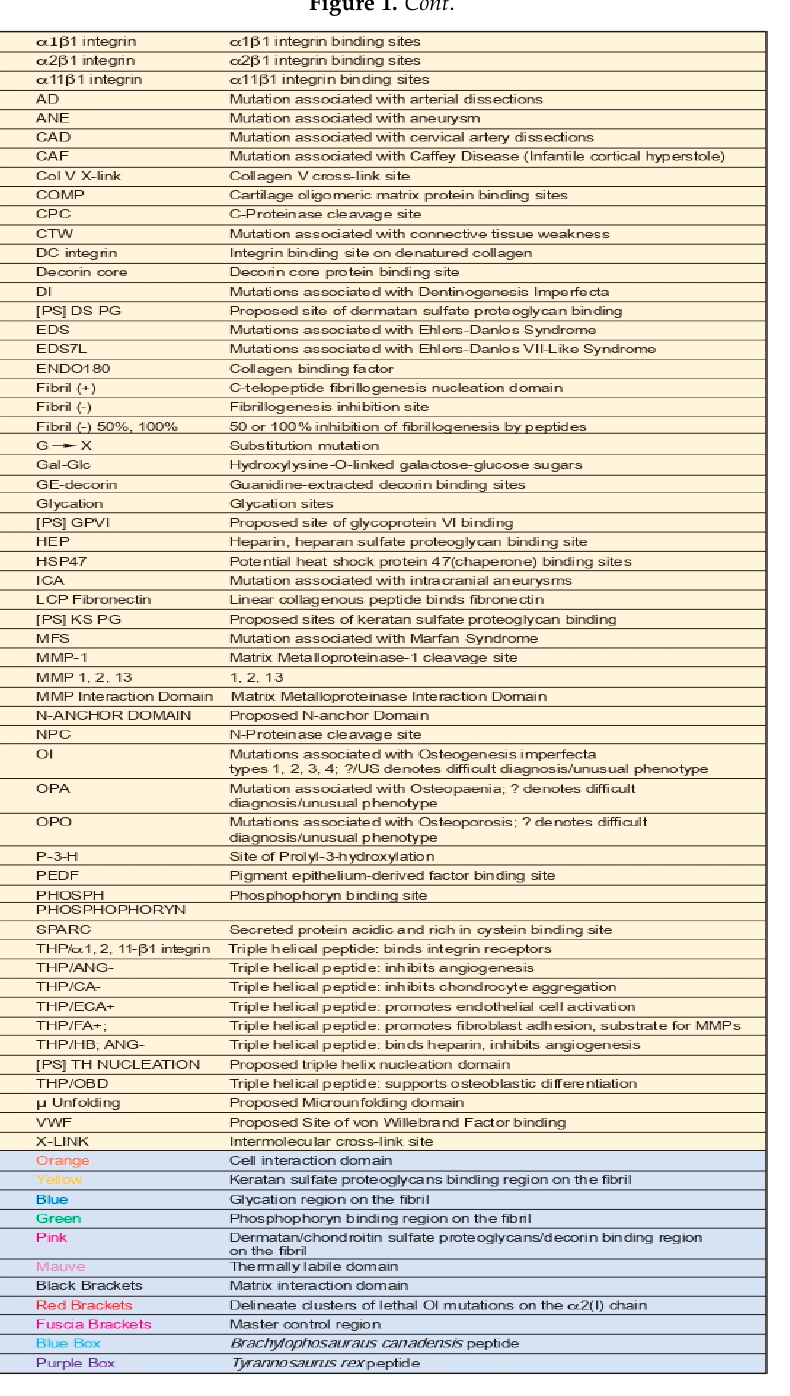
Figure 2. ( A ) Type I collagen interactome. Human collagen primary sequences were from GenBank, accession #s: a1(I), NP000079; a2(I), NP000080 and aligned as described [23] (Figure 1). Ligand binding sites are indicated by rectangular boxes adjacent to relevant collagen sequences. Gray boxes denote ligand binding to the monomer. Non-shaded boxes denote ligand binding to one α chain. Major ligand binding regions (MLBR) 1, 2, and 3 are designated. Disease-associated mutations are indicated next to affected residues. Broad cross-fibril ligand binding regions are delineated by color-shaded overlays. ( B ) Legend to type I collagen interactome ( A ) [22], listing abbreviations of mapped sites; literature citations are in [22]. Human mutation data date to 2013. This figure was modified from research originally published in the J. Biol. Chem . © the American Society for Biochemistry and Molecular Biology